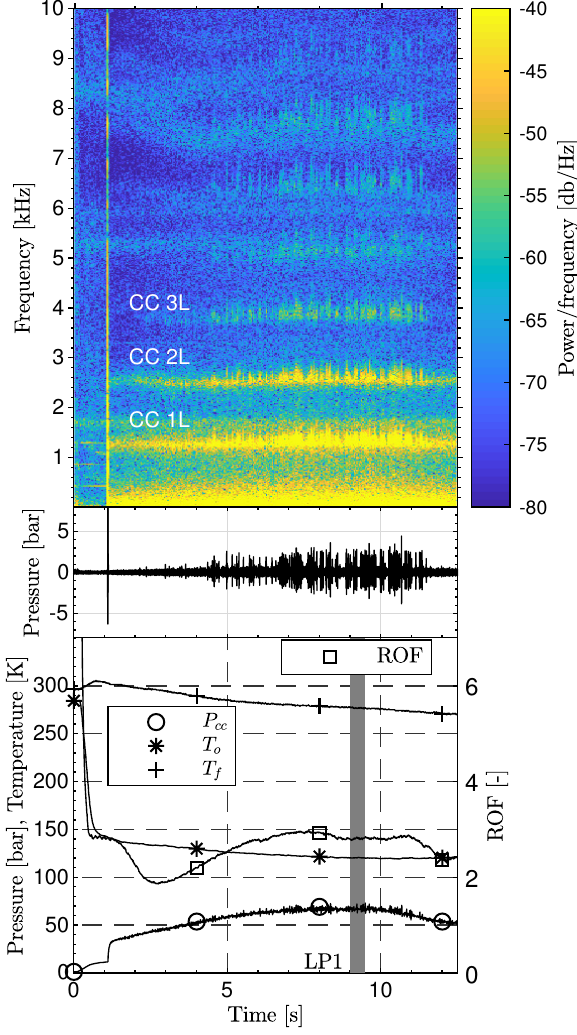
Figure 5. Test Sequences of first test with operating conditions and gray highlighted intervals used for extracting the data for load point 1. Table 2. Steady state and injection conditions for both load